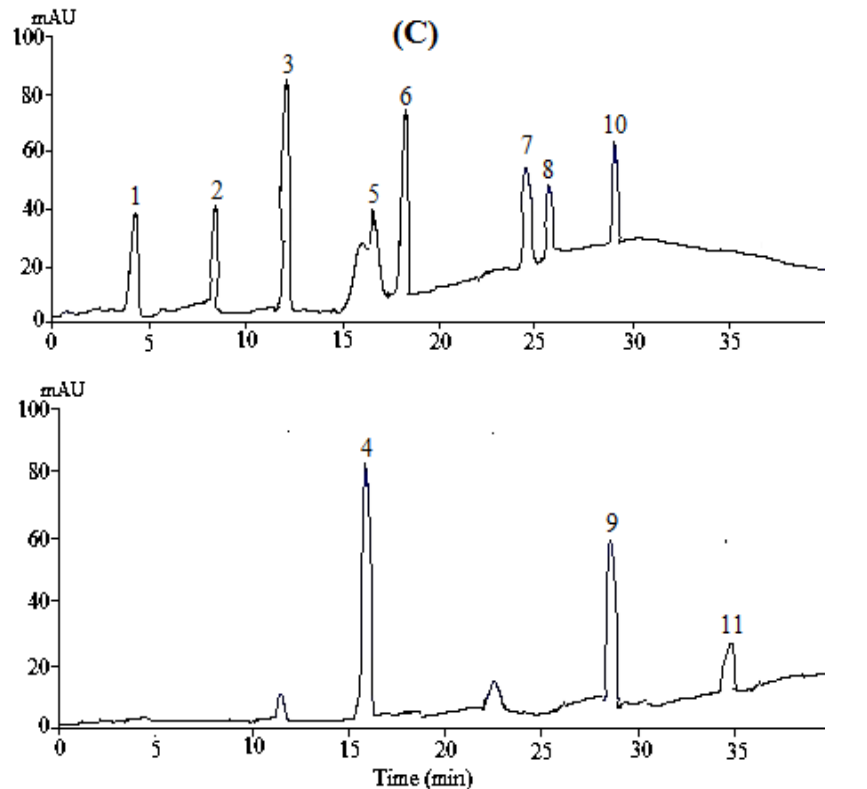
Figure 2. Phenolic contents detected in Berberis vulgaris fruits collected from ( A ): Jilin province, ( B ): Heilongjiang province and ( C ): Liaoning province. 1: Gallic acid, 2: Catechin acid, 3: Chlorogenic acid, 4: Vanillic acid, 5: Caffeic acid, 6: Syringic acid, 7: P-coumaric 8: Feulic, 9: Rutin acid, 10: O-coumaric acid and 11: Quercetin acid.